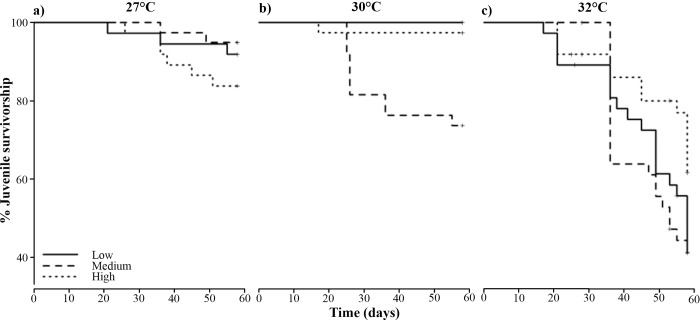
Survivorship curves of 4-month-old juveniles of Acropora tenuis that were exposed to nutrient enrichment [low (continuous line), medium (dashed line) and high (dotted line)] and temperature for 58 days.Control treatment: ‘low’ nutrient enrichment and at temperature = 27°C. Nutrient enrichment started on day one of the experiment, while heat stress started on day 21.